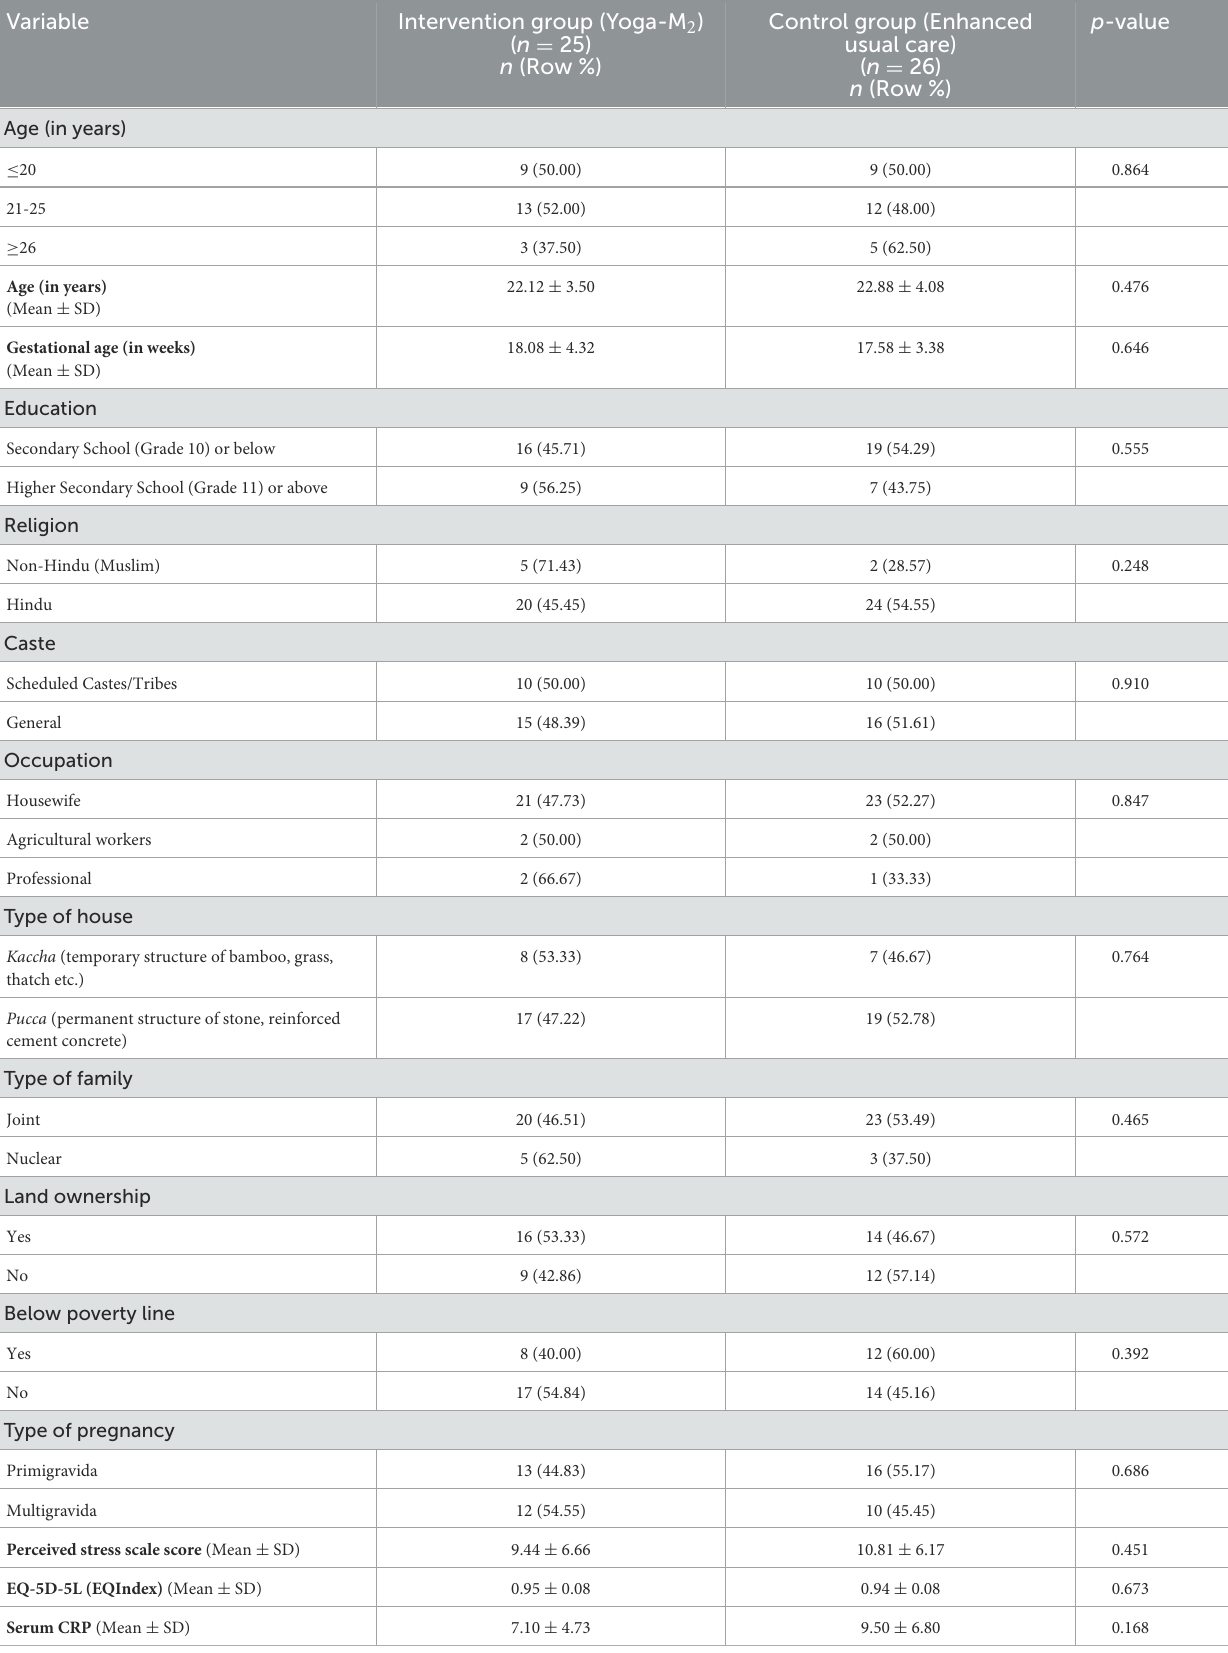
TABLE 1 Comparison of demographic and socio-economic characteristics of trial participants at baseline ( n = 51).